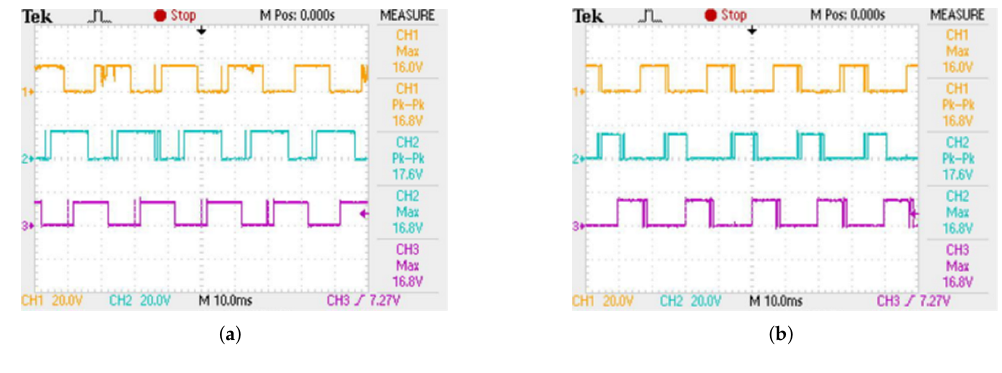
Figure 23. TLP output pulses ( a ) at (1,3,5) and ( b ) at